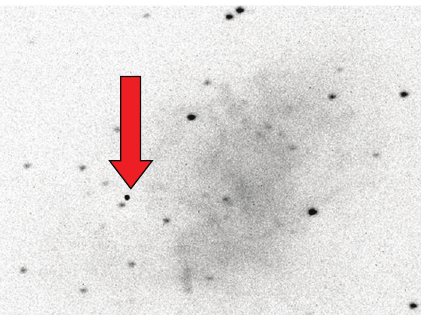
Figure 10: The OT of unknown nature: object detected on a sequence of CCD images (field M1) by the 60 cm telescope of the Brno Observatory by Filip Hroch. The estimated duration is less than 20 sec and the magnitude R = 11.